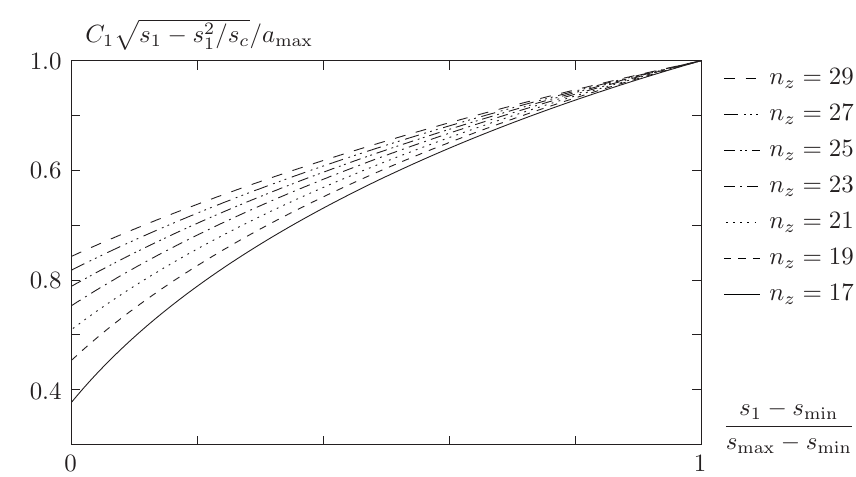
Figure 6: Normalized variation in the contact zone half-width for different number of teeth on pinion gear ranging from n z = 17 to n z = 29, the load is assumed constant along the contact line. The plot is made for a gear ratio of u = 7, β = π/ 9 and α = π/ 9..